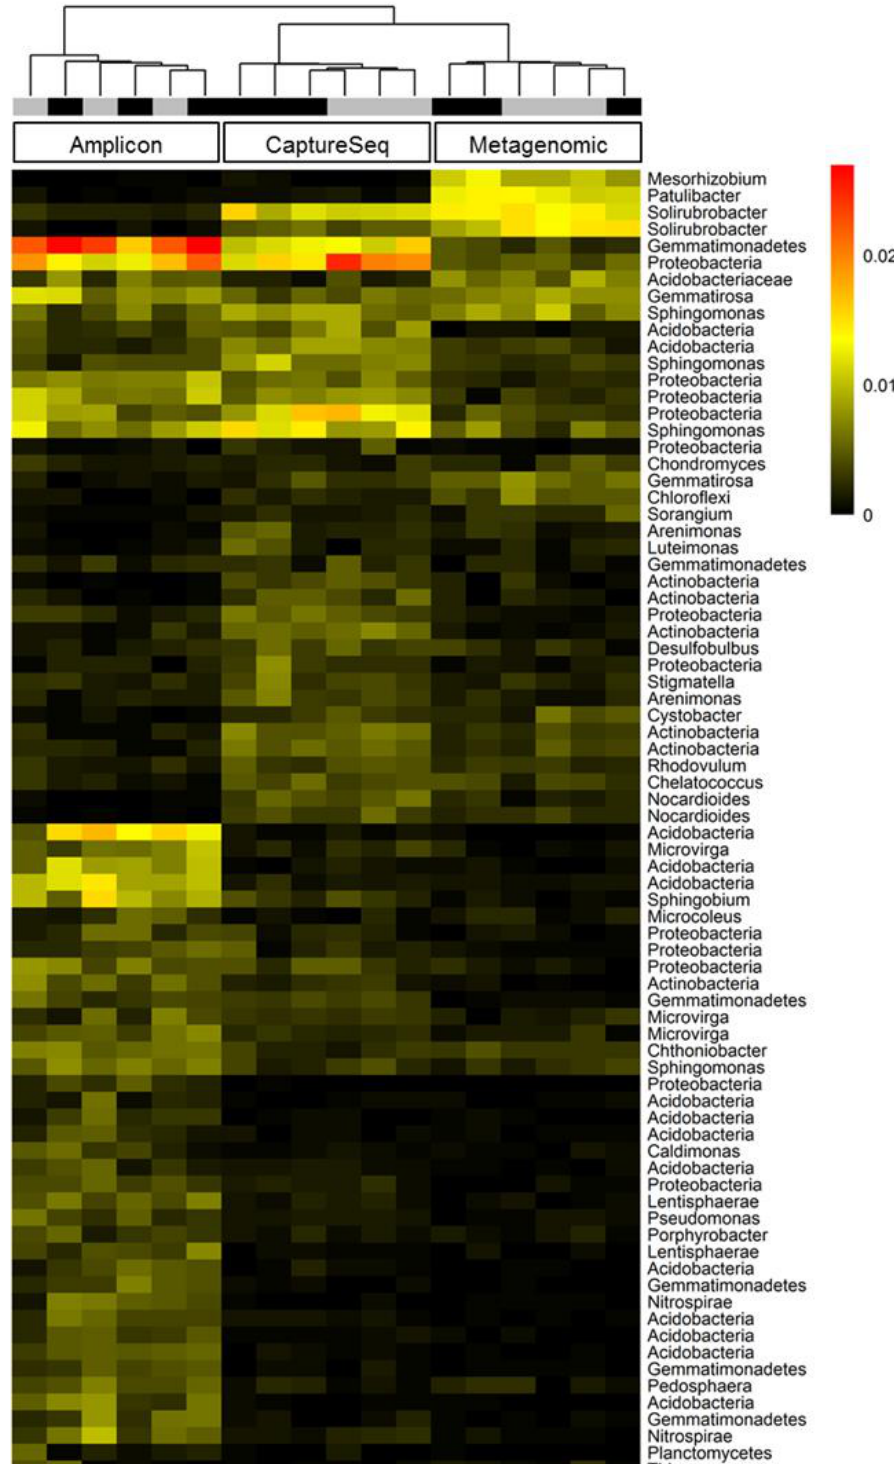
Figure 6. Proportional abundances of taxonomic clusters obtained by reference mapping for type I chaperonins in soil samples profiled using amplicon, CaptureSeq, or shotgun metagenomic ap- proaches. Samples were clustered based on Bray–Curtis distance, and reference clusters composing a minimum of 0.5% of the mapped sequencing reads in any one sample are shown. Samples are coded according to antibiotic treatment: black (10 ppm) or gray (0 ppm).